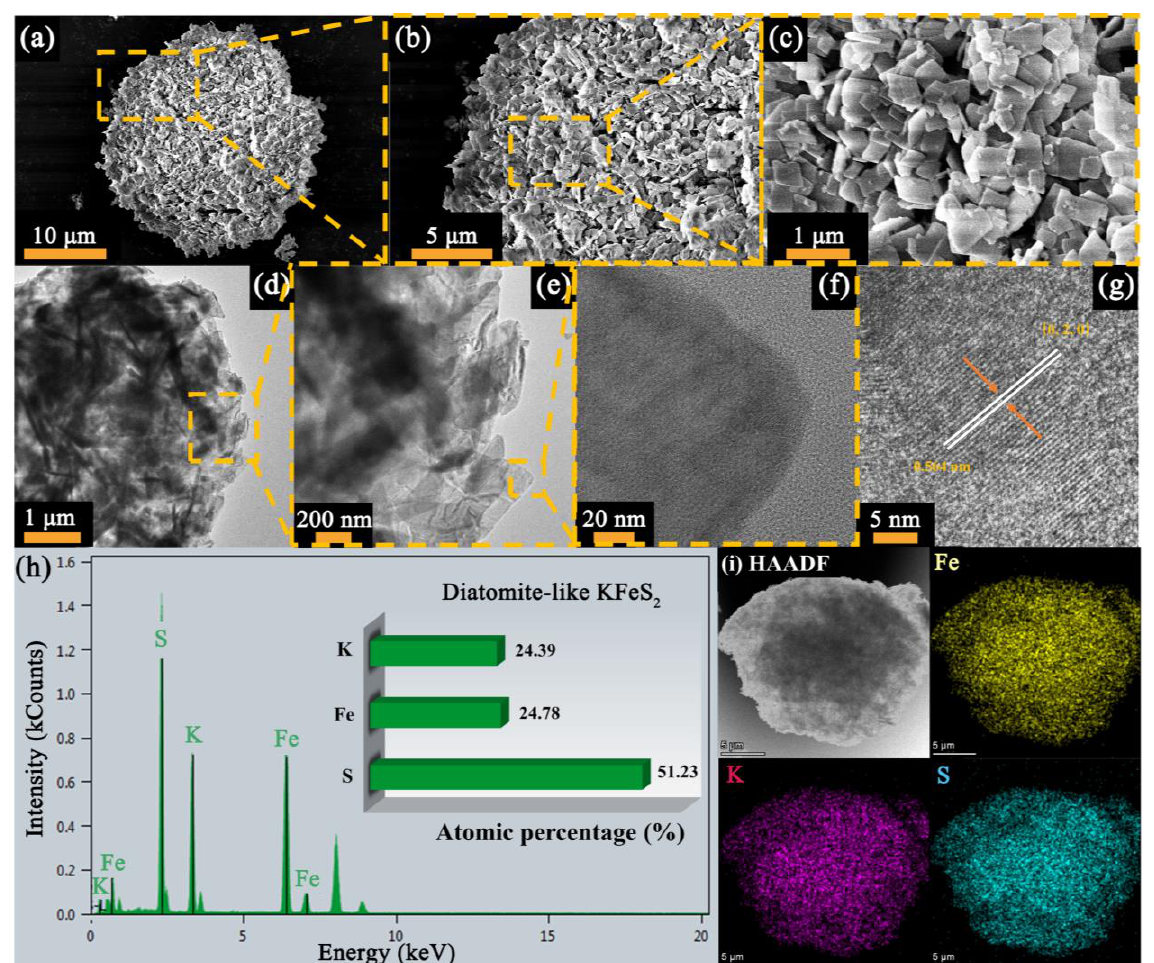
Figure 1. ( a – c ) Magnification increases for the SEM images of the diatomite-like KFeS 2 ; ( d – f ) Magnification increases for the TEM images of the diatomite-like KFeS 2 ; ( g ) Typical TEM image of the diatomite-like KFeS 2 single wire; ( h ) EDS mapping of diatomite-like KFeS 2 ; ( i ) HAADF-STEM images and corresponding EDS mapping of diatomite-like KFeS 2 .